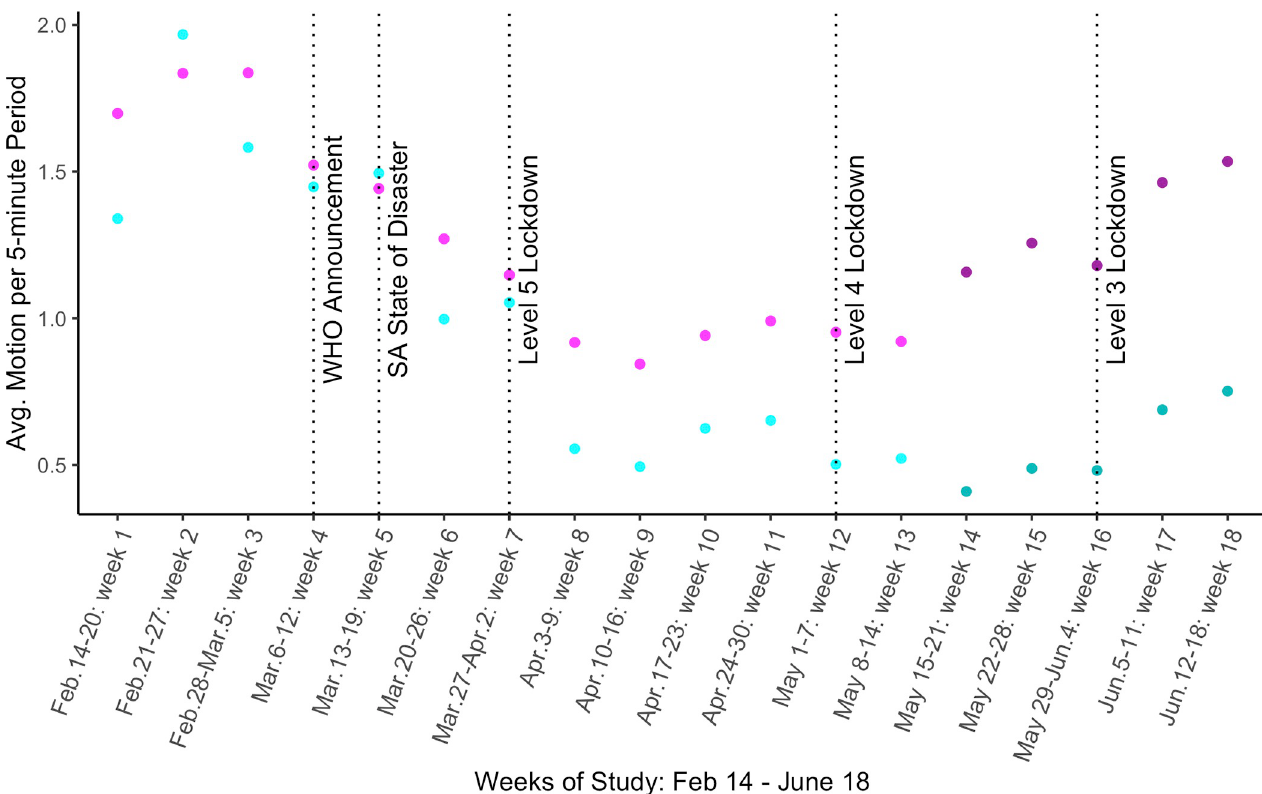
Fig 2. Average five-minute motion by week of the study. The plot shows mean five-minute motion by week of the study. Pink points represent path means; blue points represent compound means. Underlying data is the same as in Fig 1. Dark pink and dark blue points indicate means from the restricted dataset that adds weeks 14–18 to the study period. Means in the restricted dataset prior to week 14 are generally similar, but the pattern is a bit noisier. The coefficient is significant in each week in the main study period (weeks 1–13) for both paths and compounds. See S1 Table. A version of this graph with only data from the restricted dataset see S4